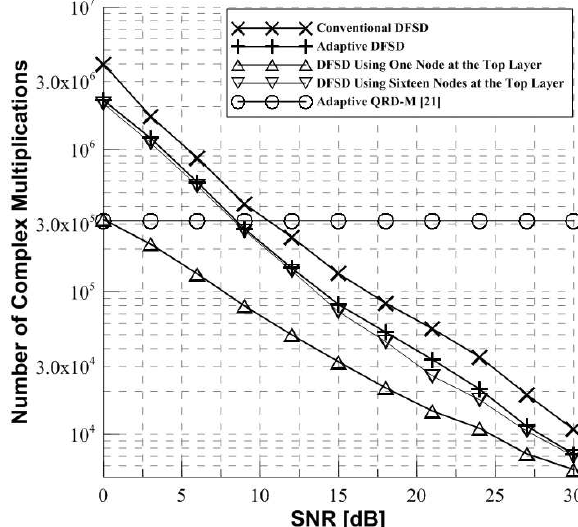
Figure 11. The complexity of the detection schemes in 4 × 4 MIMO-OFDM system with